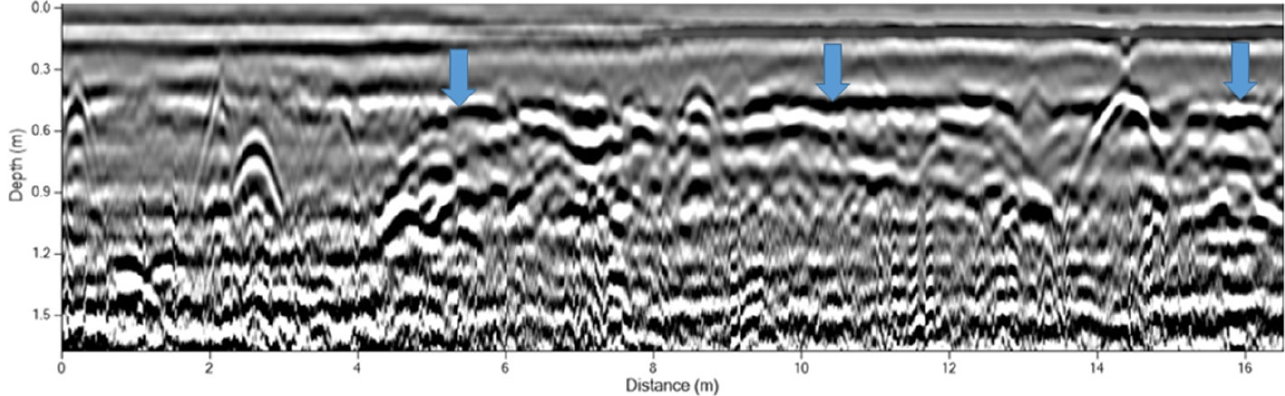
Figure 6. Perpendicular wall crossing at 7–8 m in Grid 2 transect at foundation of 5th Mission Complex, Mission Santa Clara.